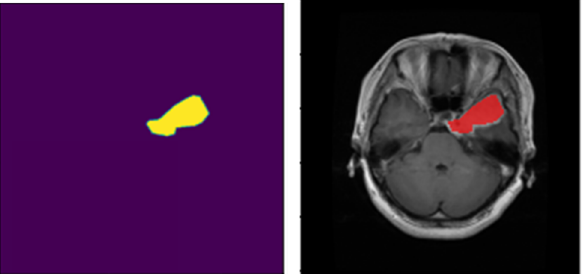
Figure 9: Segmentation of the input